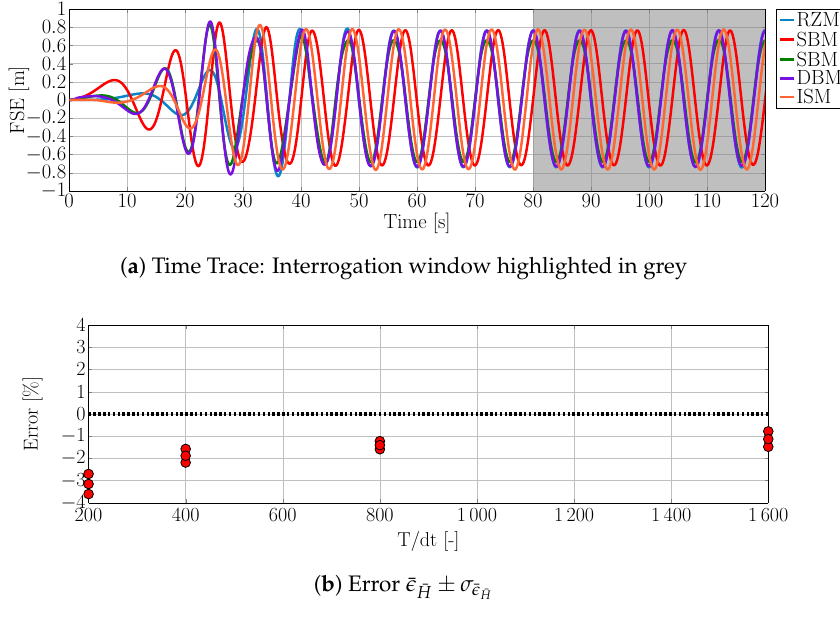
Figure 14. Example plots of the free surface elevation time traces for different NWMs ( a ) and the time σ ¯ (cid:101) step sensitivity on the error ¯ (cid:101) ¯ ( b ) for the SBM using the olaFlow toolbox. For brevity, results are H ± ¯ H only shown for the OFWP. σ ¯ (cid:101) between target and resulting wave height for different time step sizes NWMs Table 10. Error ¯ (cid:101) ¯ H ± ¯ H and